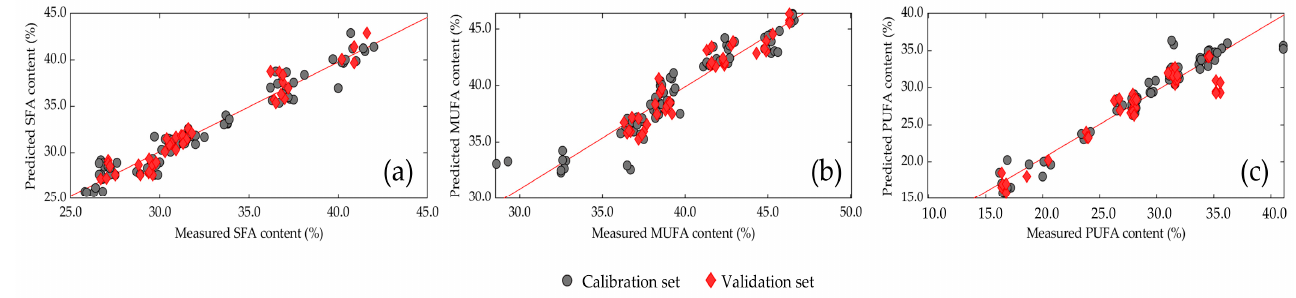
Figure 6. Comparison of the measured and predicted values of ( a ) saturated fatty acids (SFA), ( b ) monounsaturated fatty acids (MUFA), and ( c ) polyunsaturated fatty acids (PUFA) of living mealworm larvae in the calibration (•) and validation sets ( ♦ ).